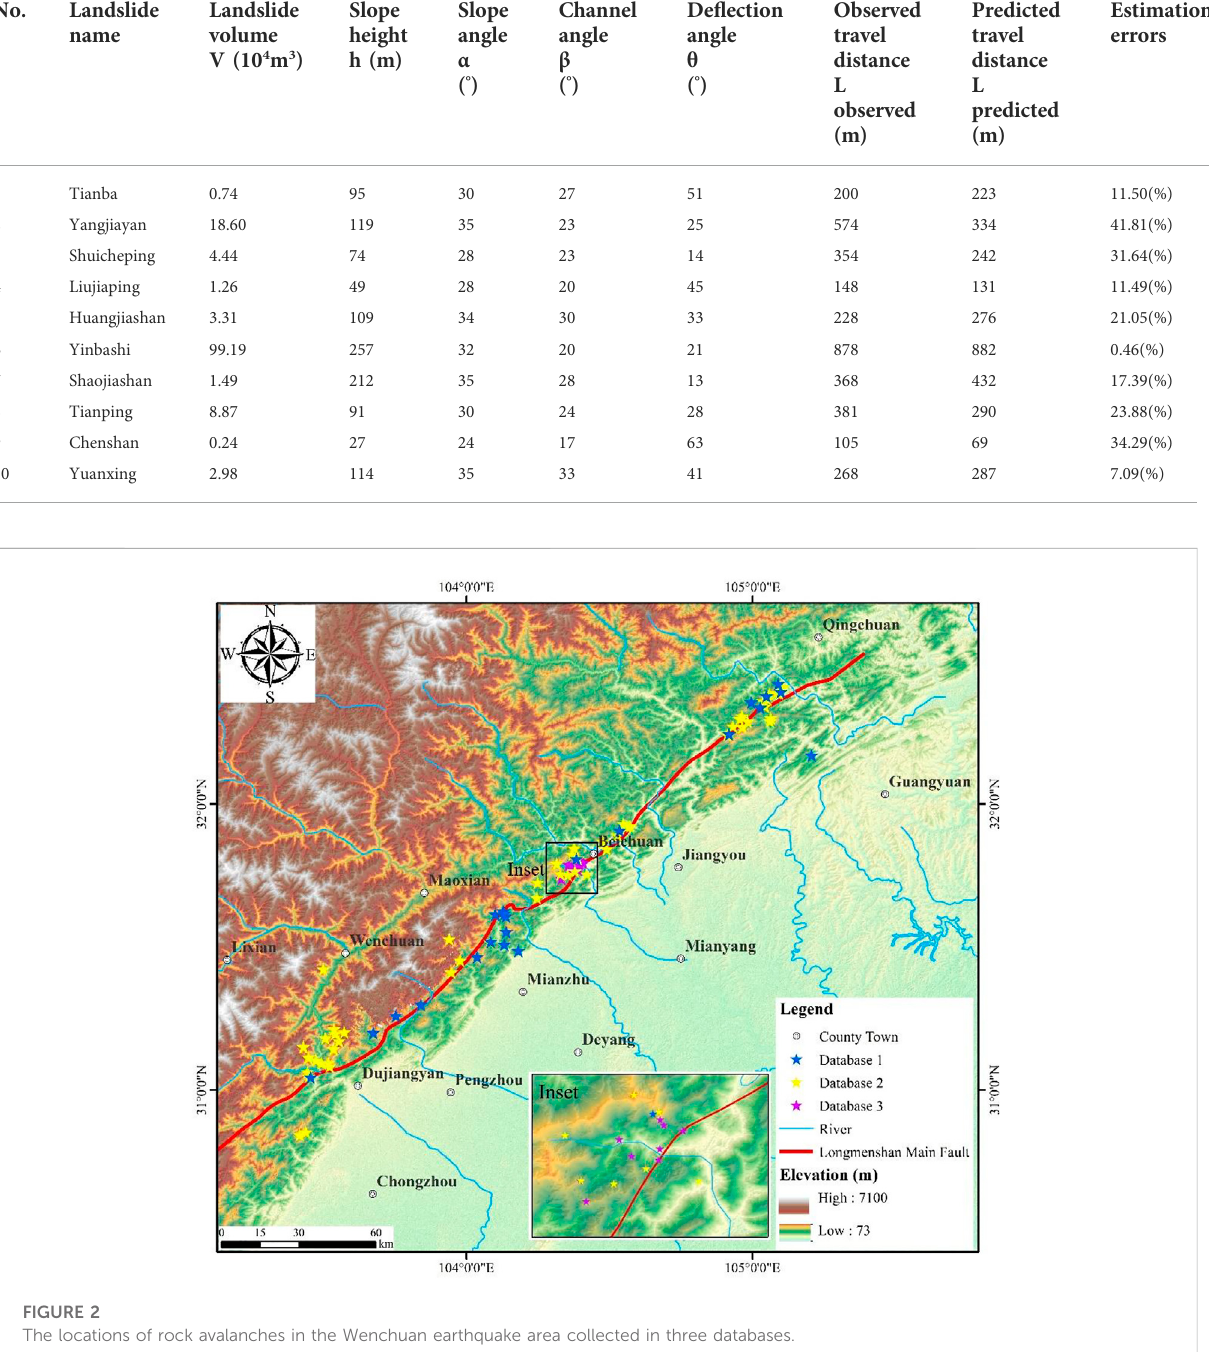
scarp(Qiuetal.,2018). Thechannel angle(denotedas β )referstothe